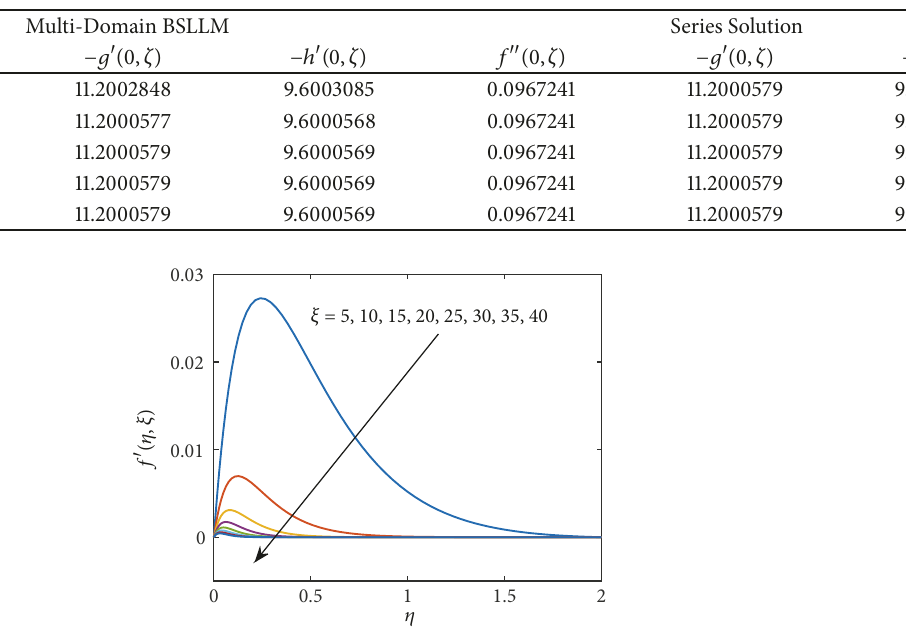
Table 6: Comparison of the multidomain solution and the series solution for 𝑓 󸀠󸀠 (0,𝜁) , −𝑔 󸀠 (0,𝜁) , and −ℎ 󸀠 (0,𝜁) : 𝑁 𝜂 = 60 , 𝑁 𝜁 = 5 , 𝜂 ∞ , 𝑛 = 𝑤 = 1/2 , 𝑃𝑟 = 0.7 , 𝑆𝑐 = 0.6 , and 𝑧 = 40 .